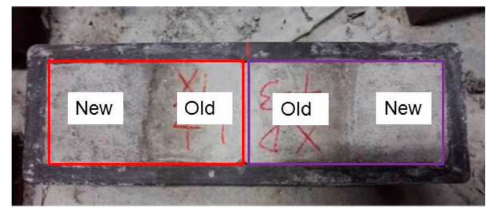
Figure 13. Two concrete combinations in one mold.